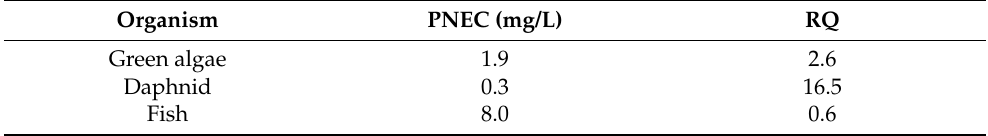
Table 2. The PNEC and RQs of CTC for green algae, daphnid, and fish in water. Organism PNEC (mg/L) RQ Green algae 1.9 Fish